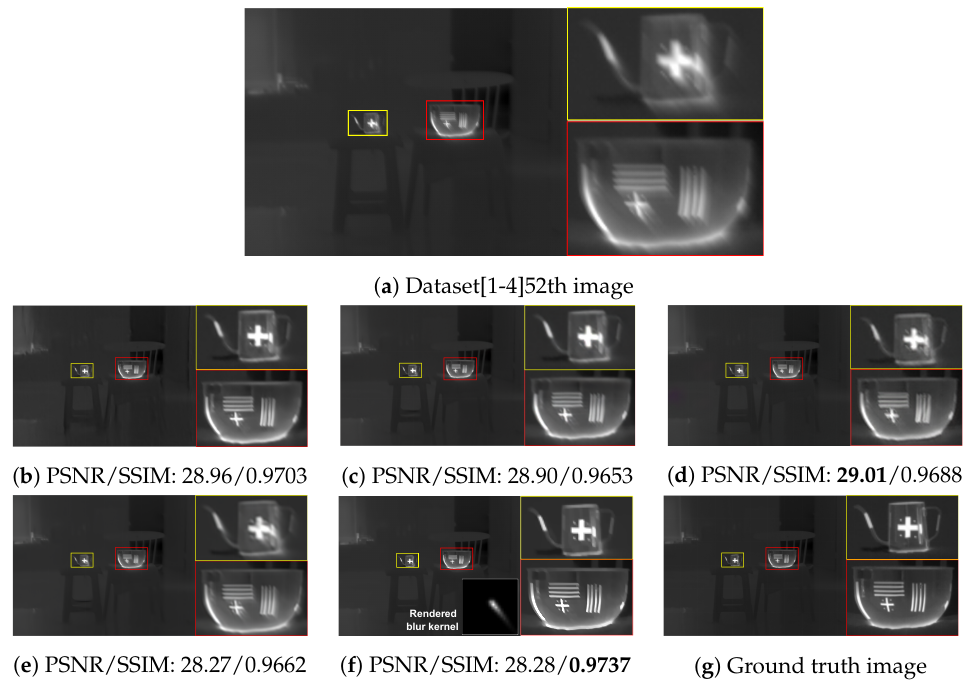
Figure 11. Qualitative comparison of deblurring results on the SBTI dataset [1-4]54th. ( a ) Synthetic blurry thermal image, ( b ) SRN [33], ( c ) SIUN [36], ( d ) DeblurGAN.v2 [35], ( e ) CDVD [34], ( f )